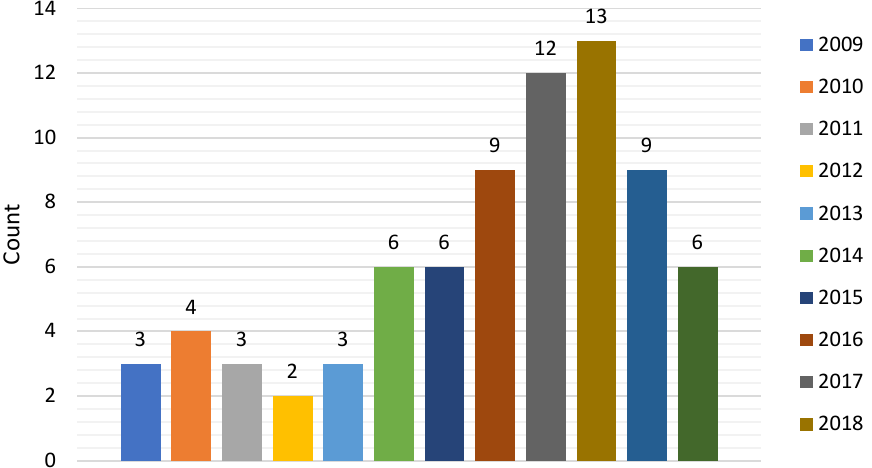
Figure 3. Year-wise publication count from 2009 to 2020.